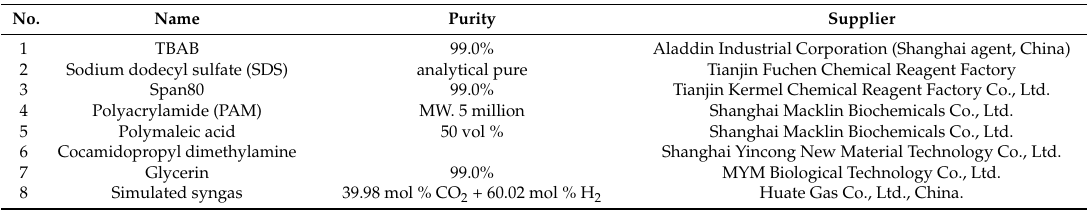
Table 5. The chemical reagents used in this